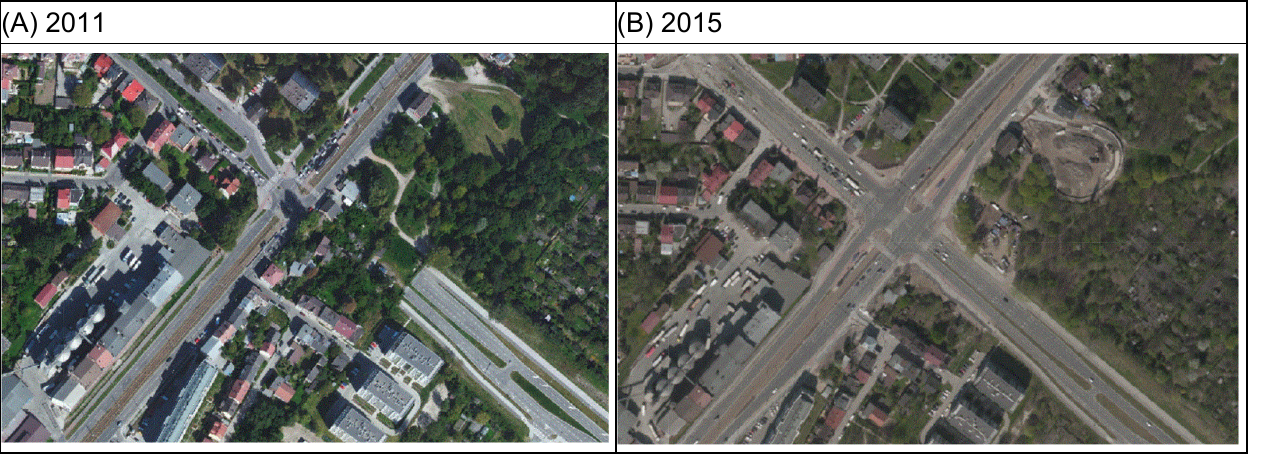
Figure 2. Example illustrating the effect of lengthy expropriation proceedings on the